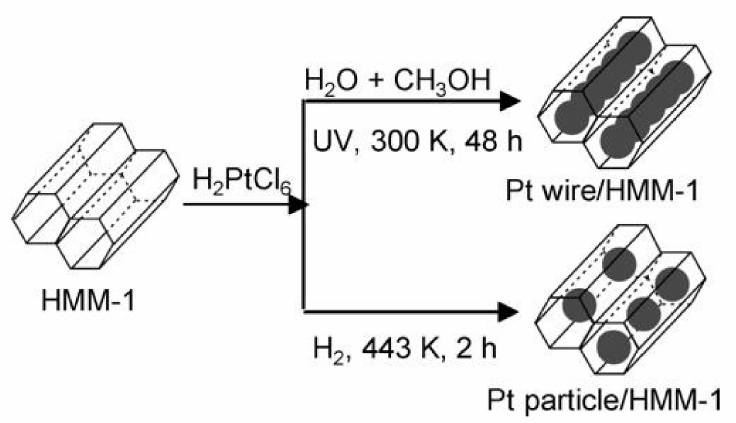
Figure 12. Schematic presentation of the synthesis of Pt nanowires and nanoparticles in HMM-1. Reprinted with permission from Reference [106]. Copyright (2004) American Chemical Society.